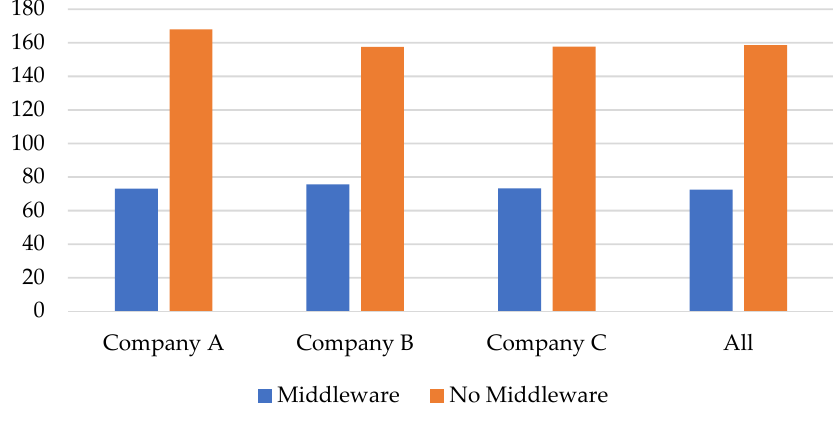
Figure 10. Elapsed time results (in seconds).